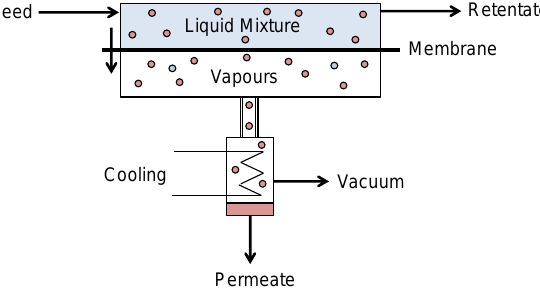
Figure 11. Schematic of a typical pervaporation process.